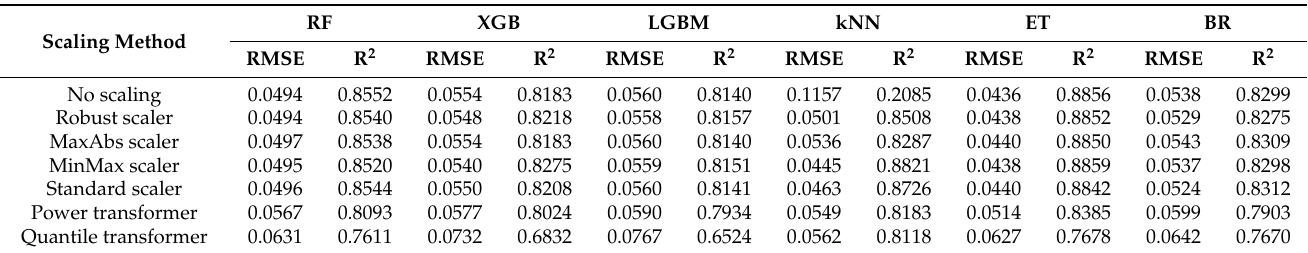
Table 7. The effect of different scalers on NH 4 prediction in The